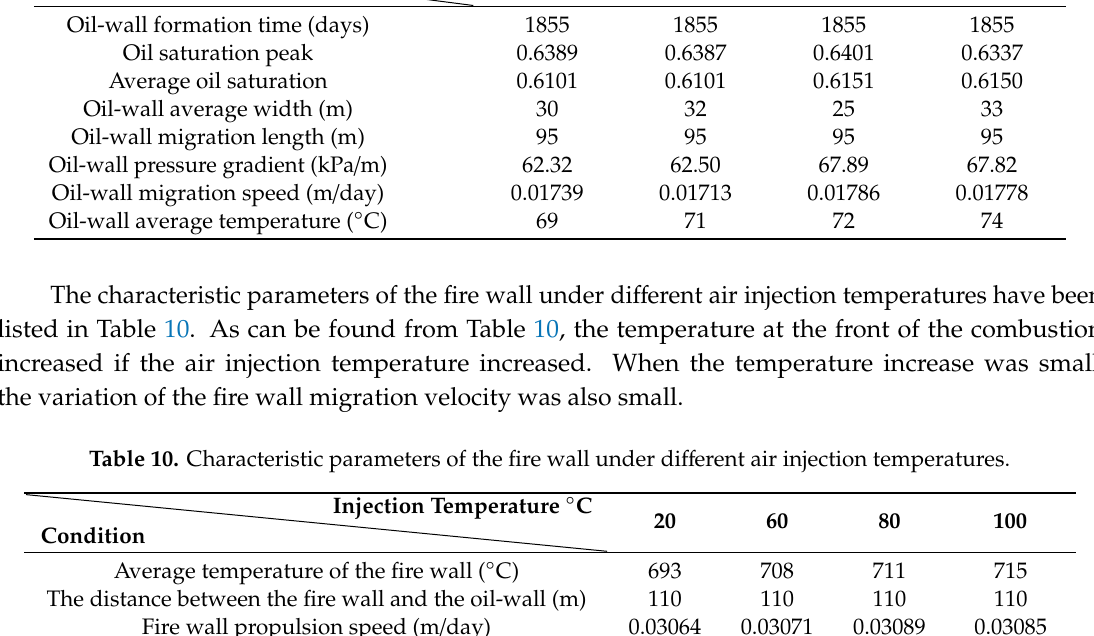
Figure 8. Comparison of the production indicators under different bottom water thickness. ( a ) recovery degree; ( b ) cumulative oil production; ( c ) gas-oil ratio; and ( d ) gas production rate. The dynamic production indicators under different bottom water thicknesses have been listed in Table 11. As can be found from Table 11, with the increase of the thickness of the bottom water, the oil recovery degree and the accumulated oil production were increasing; the gas appearance time in production well was almost the same; and the peak of gas-oil ratio decreased.